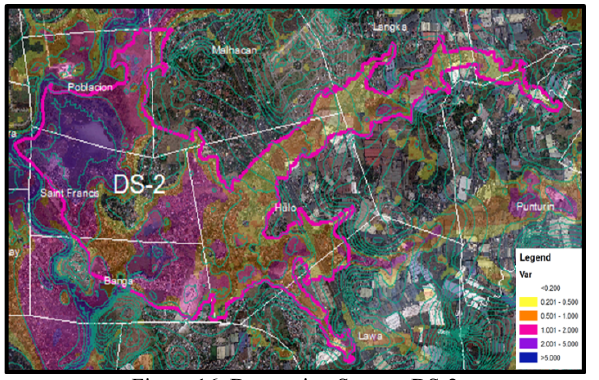
Figure 16. Depression Storage DS-2